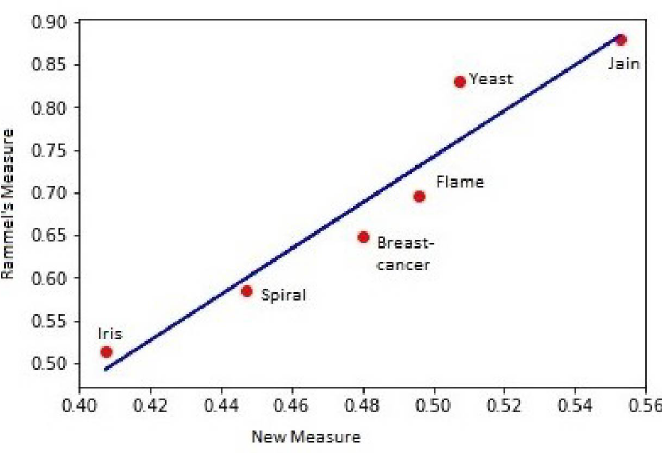
Figure 9. Rammal’s measure is pointing in the same direction as our new